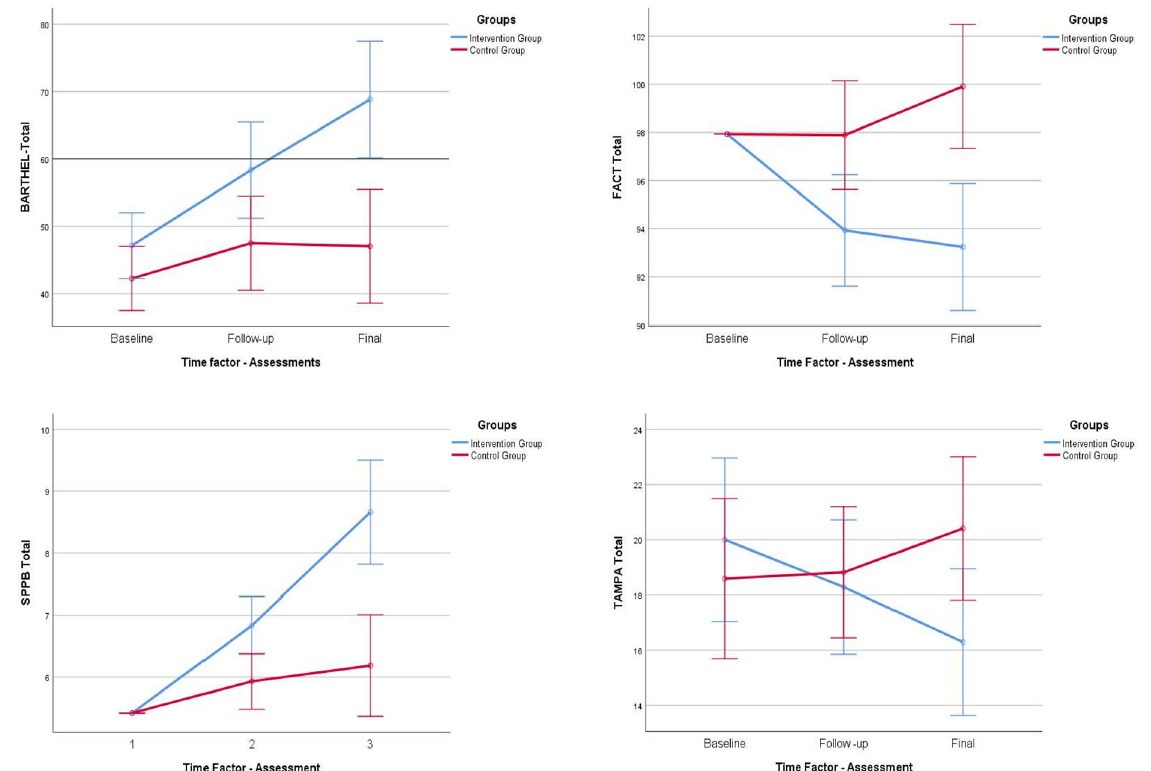
Figure 2. Within-group behavior and follow-up of score, Barthel Index, SPPB, TAMPA, and FACT-An. Comparisons between both groups. IG, Intervention group; CG, control group; FACT-An, Functional Evaluation of Cancer Therapy-Anemia; SPPB, short physical performance battery.